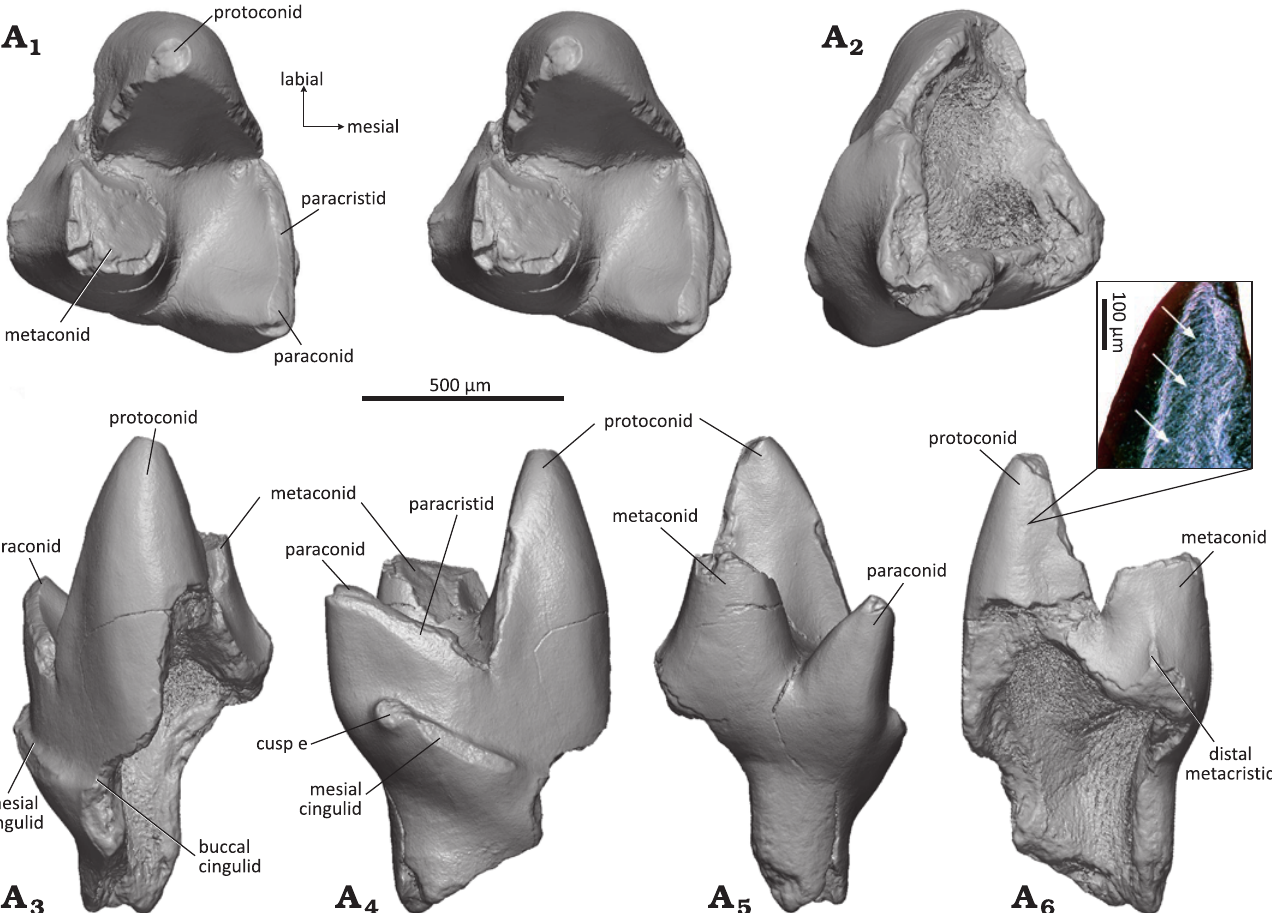
Fig. 8. Dryolestid mammal Minutolestes submersus gen. et sp. nov., WMNM P82307 from Busche Quarry near Balve, North Rhine-Westphalia, Germany, Barremian–Aptian (Lower Cretaceous). Left lower molar in occlusal (stereopair, A 1 ). ventral (A 2 ), labial (A 3 ), mesial (A 4 ), lingual (A 5 ), and distal (A 6 ) views. Enlarged inset of protoconid (stereo microscopic image under sided light) showing striations